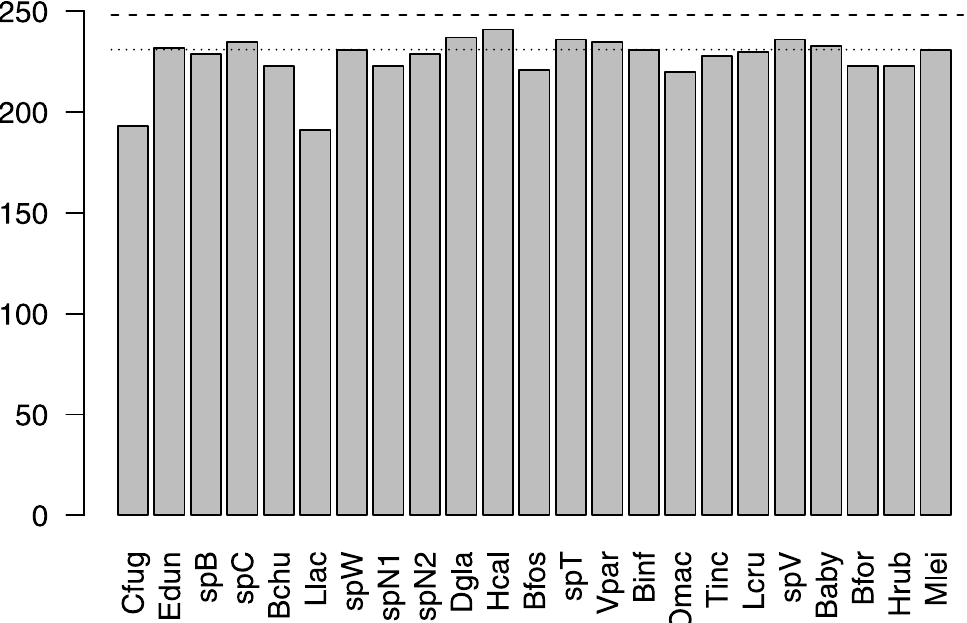
Fig 2. Survey of conserved genes across ctenophore transcriptomes. Dashed line indicates the maximum number of genes in this set, 248. The dotted line indicates the number of genes found in the Mnemiopsis leidyi genome. Most of the transcriptomes recovered a comparable number of genes as the genome. Species abbreviations are as follows: Bfos, Bathocyroe fosteri ; Bchu, Bathyctena chuni ; Baby, Beroe abyssicola ; Bfor, Beroe forskalii ; Binf, Bolinopsis infundibulum ; Cfug, Charistephane fugiens ; Dgla, Dryodora glandiformis ; Edun, Euplokamis dunlapae ; Hrub, Haeckelia rubra ; Hcal, Hormiphora californensis ; Llac, Lampea lactea ; Lcru, Lampocteis cruentiventer ; Mlei, Mnemiopsis leidyi ; Omac, Ocyropsis maculata ; Tinc, Thalassocalyce inconstans ; spB, Undescribed ctenophore B ; spC, Undescribed ctenophore C ; spN1, Undescribed ctenophore N1 ; spN2, Undescribed ctenophore N2 ; spT, Undescribed ctenophore T ; spV, Undescribed ctenophore V ; Vpar, Velamen parallelum